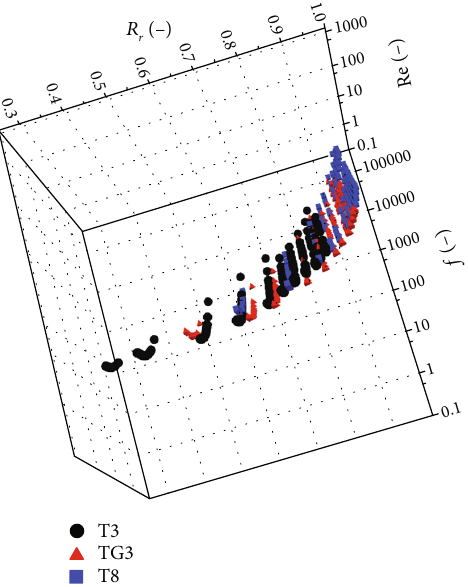
Figure 16: Friction factor as a function of the Reynolds number and the relative